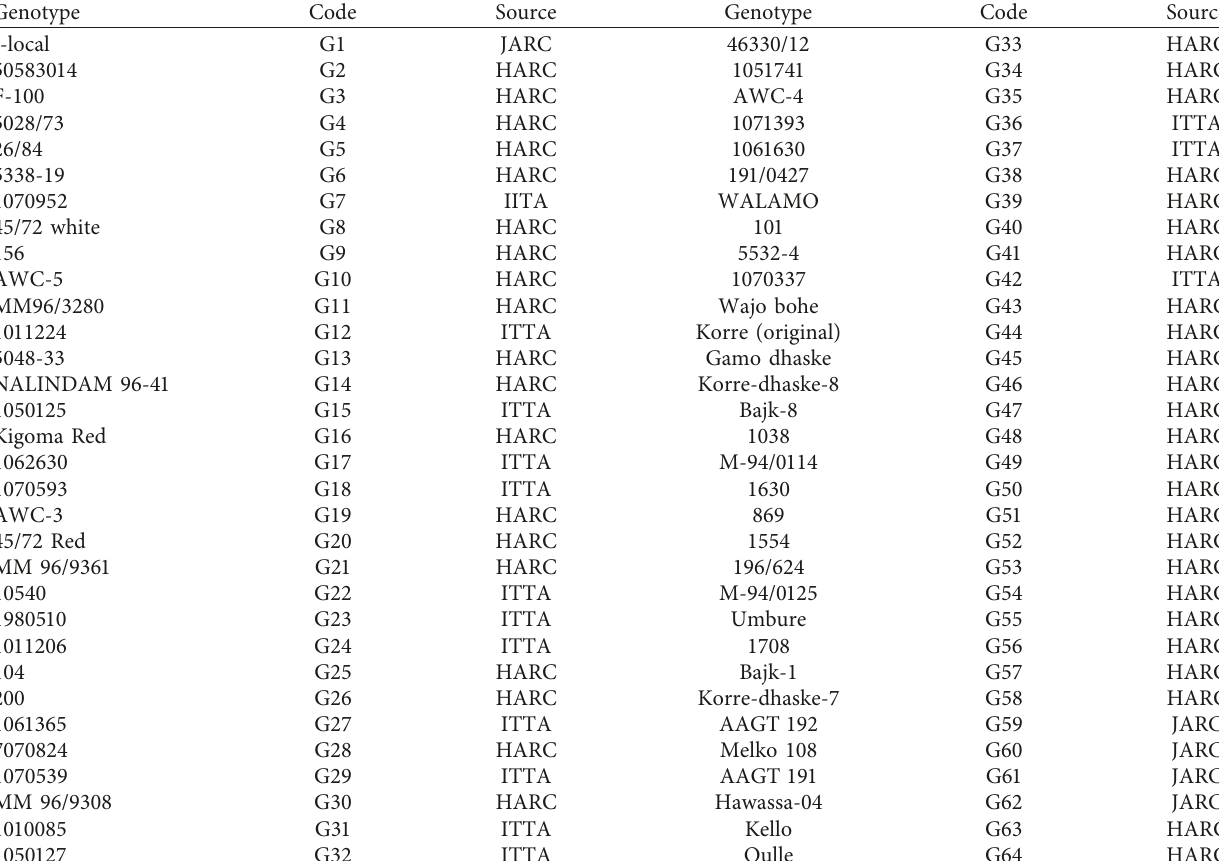
Table 1: List of cassava accessions used in the study with their corresponding code and source. Genotype